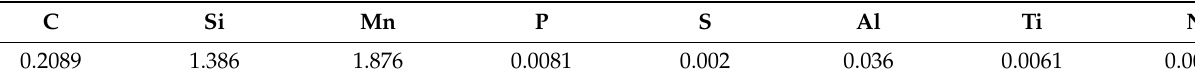
Table 1. Chemical compositions of QP980steel sheet (wt %).